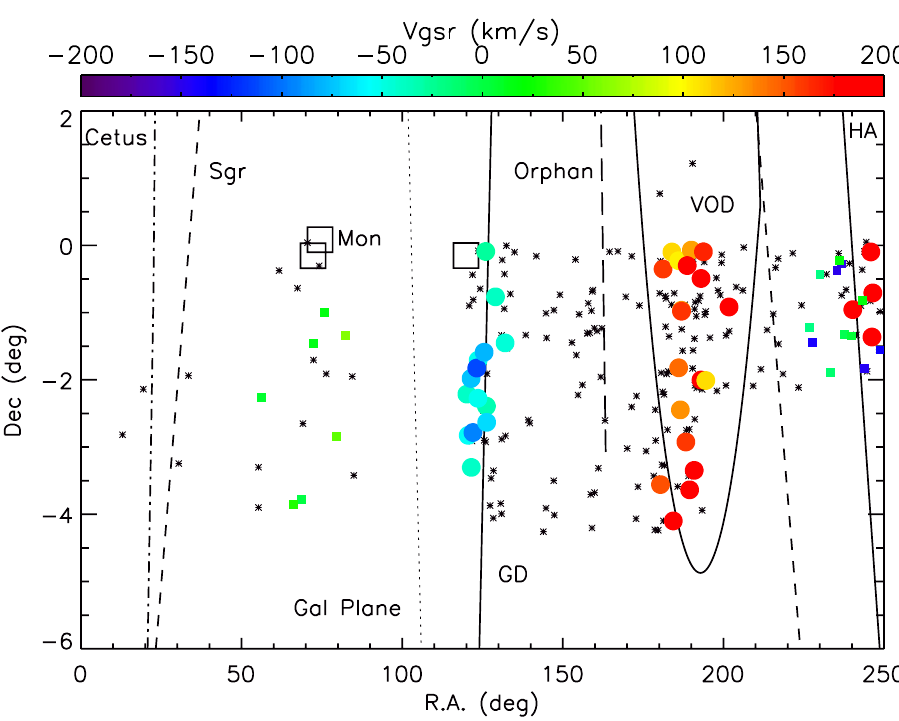
Figure 1. Distribution in the sky of the QUEST RR Lyrae stars with spectroscopy. The color symbols show RR Lyrae stars belonging to groups. For reference we have shown with different lines the Sagittarius Plane (Sgr), the Orphan, Cetus and Grillmair-Dionatos (GD) streams, the Hercules-Aquila cloud (HA), the Virgo Overdensity region (VOD), and detections of the Monoceros ring (Mon) in the region. With the method described above we have detected two significant groups in the VOD region with velocities (in the galactic standard of rest) of 142 and 221 km/s. The first one is located at a mean distance of 19kpc, and corresponds to the Virgo Stellar Stream [6]. The second group has stars between 8 and 16kpc. A third group with lower probability was also found at − 86 km / s, but it is not shown here for clarity. In the region of the Hecules-Aquila cloud we detected three different kinematical groups with V gsr = 185, − 146 and − 3 km / s, in the distance range from 4 to 11 kpc from the Sun. We have found also a significant group along the GD stream, but its velocity ( − 59km / s) does not agree with the detection by